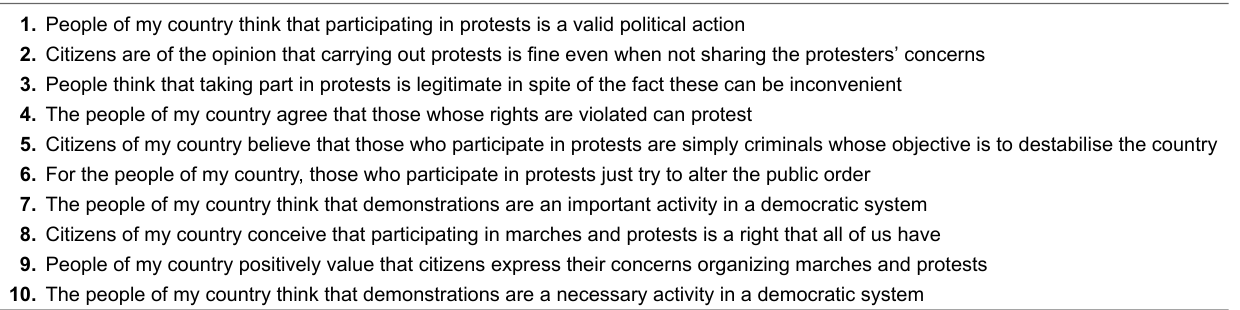
Items Created to Measure Legitimacy of Protests (Original Scale)